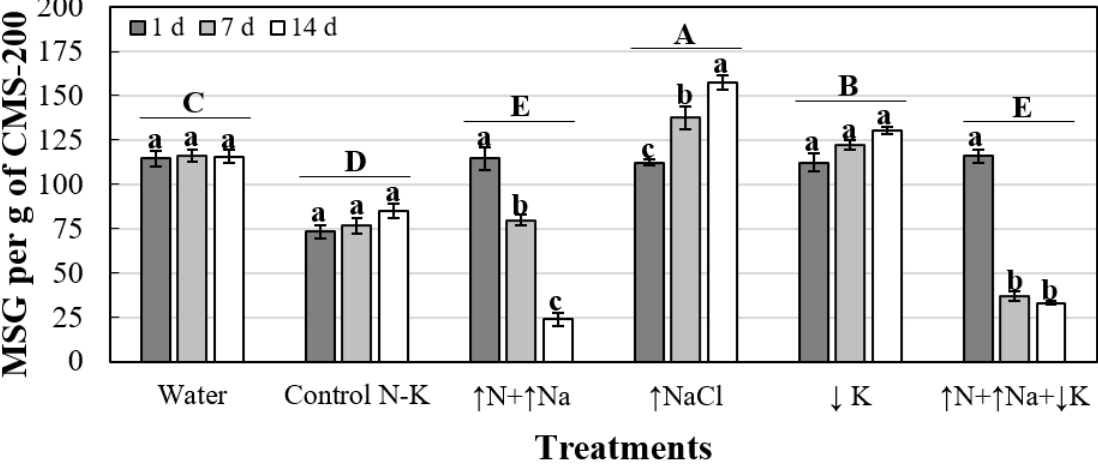
Figure 1. Effects of treatment and exposure period (1, 7 or 14 days) on microsclerotia germination of V. dahliae isolate V323 (MSG; number of germinated MS per g of CMS-200). For each treatment and exposure period combination, columns represent the means of MSG values of three replicated samples of CMS-200. For each treatment, columns with a common lowercase letter do not differ significantly according to orthogonal contrasts. Treatments with a common capital letter do not differ significantly according to Fisher’s protected LSD test at P = 0.05 for MSG at 14 days of exposure. Vertical bars represent the standard errors of the mean.